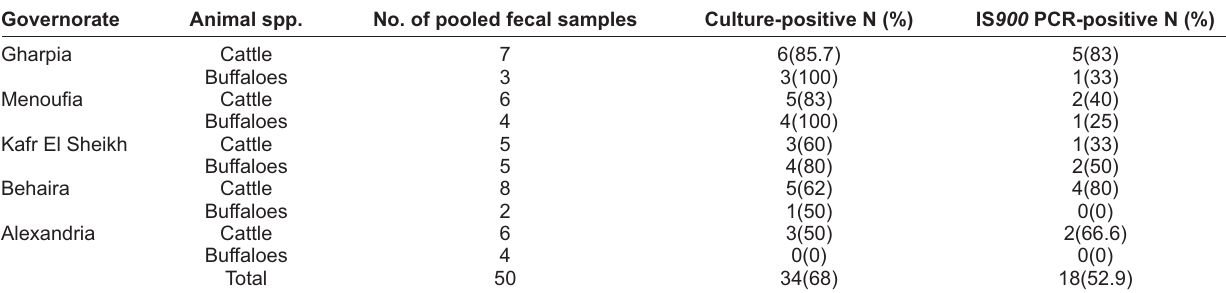
Figure-5: A representative agarose gel with the IS specific primers, which generate a fragment that migrates at a molecular weight of 229 bp for the 34 culture-positive pooled fecal samples. Lane 1: 1000 bp DNA ladder; Lane 2: as a negative DNA control; Lane 3: a standard strain of MAP as a positive control; Lane 4: a master-mix blank control. Other lanes: Positive (presence of 229 bp amplicons) and negative (absence of 229 bp amplicons) IS PCR. Arrow shape: 229 bp amplicons.